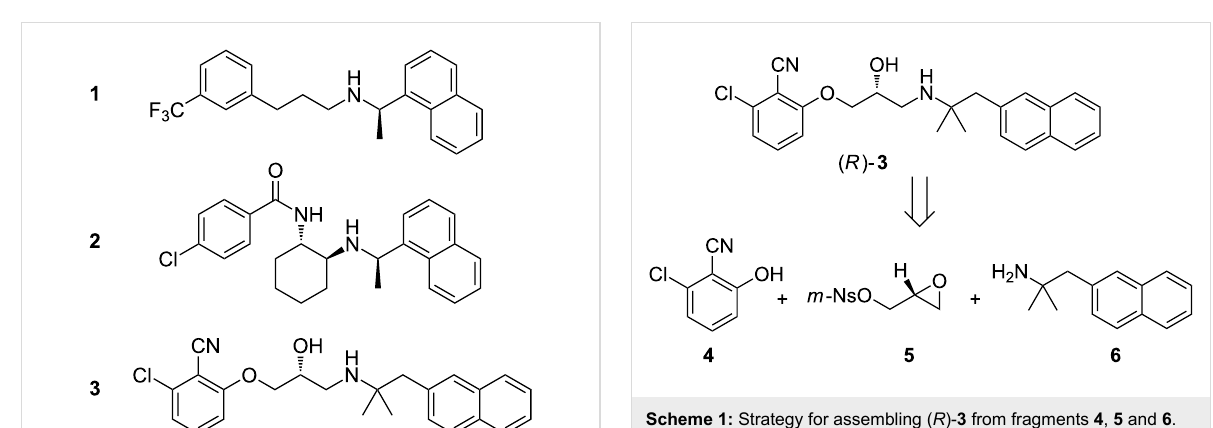
certain cell types [6-8]. The CaSR is involved in